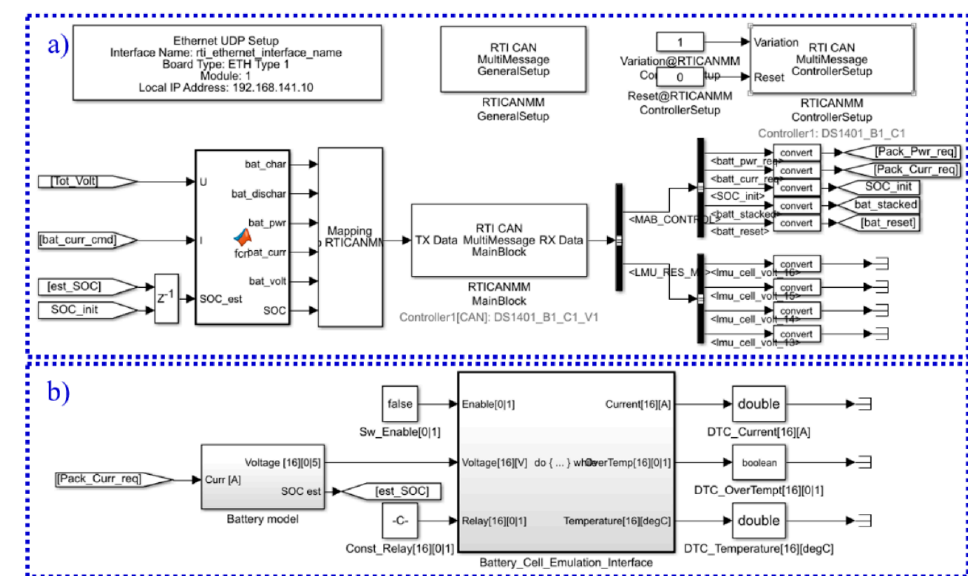
Figure A2. Matlab/Simulink model for MAB (( a ) CAN configuration, ( b ) battery